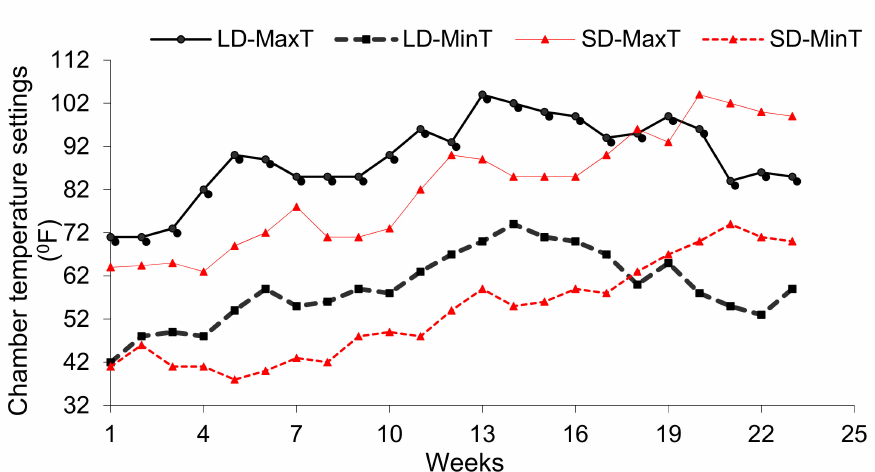
Figure 2. Weekly average maximum and minimum temperature setting of the chambers. LD-MaxT (Long-day Maximum temperature), LD-MinT (Long-day minimum temperature), SD-MaxT (Short-day maximum temperature) and SD-MinT (Short-day minimum temperature). Temperatures are based on 2005 weather station data for Palmdale, California (http: // www.cimis.com). Chamber settings were in ◦ C, but converted into ◦ F using the formula, ◦ F = ◦ C × 1.8 + 32.